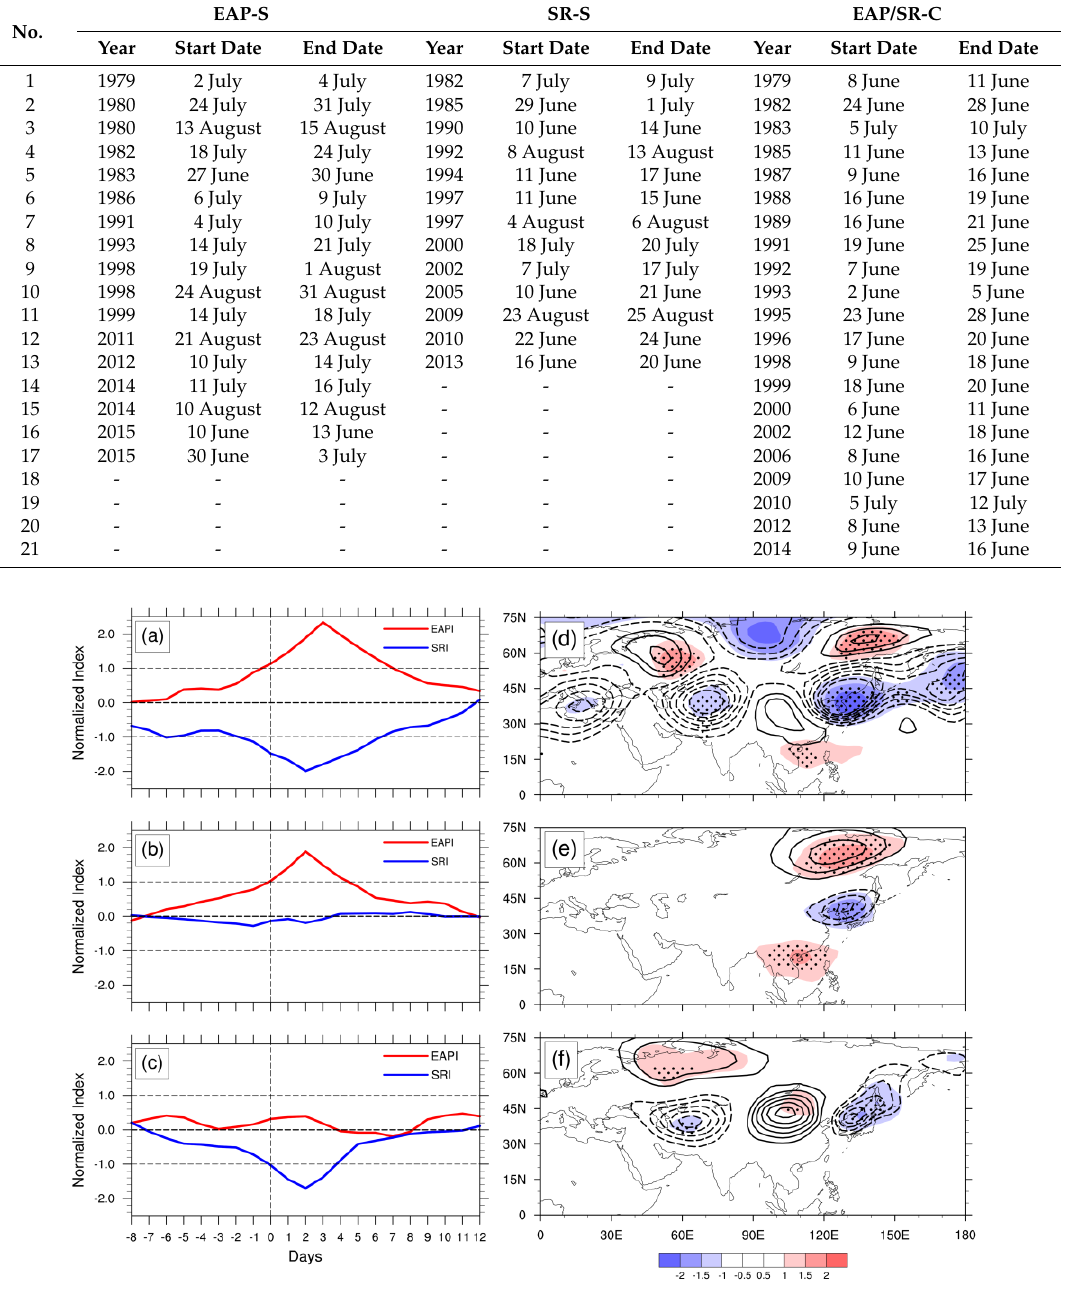
Table 1. The years, start dates, and end dates of single EAP (EAP-S), single SR (SR-S), and combined EAP and SR (EAP/SR-C) events.